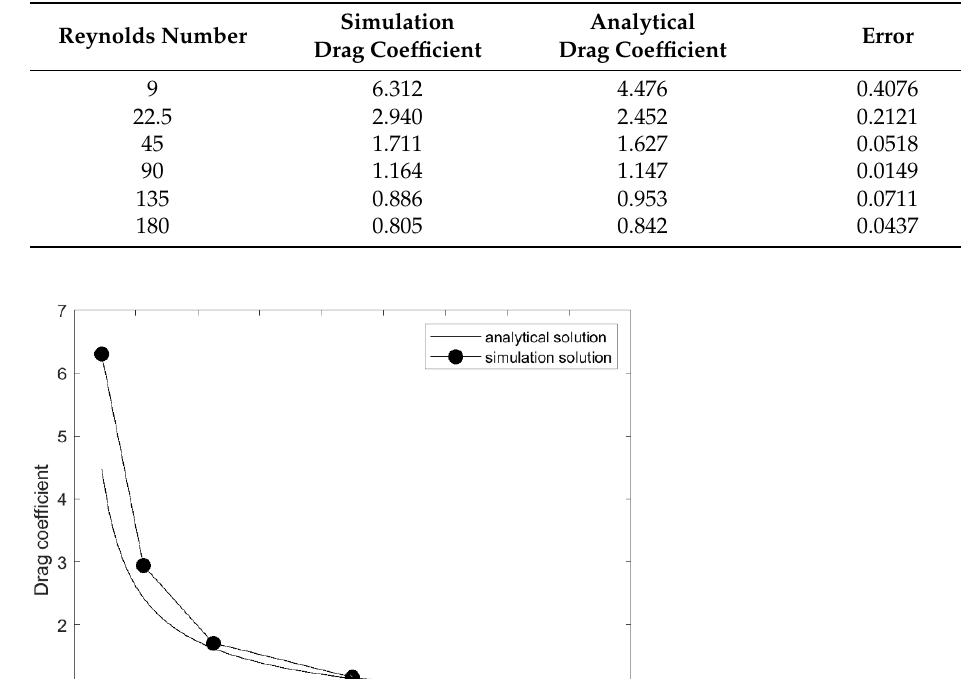
Table 1. Simulation and analytical drag coefficient of different Reynolds number.